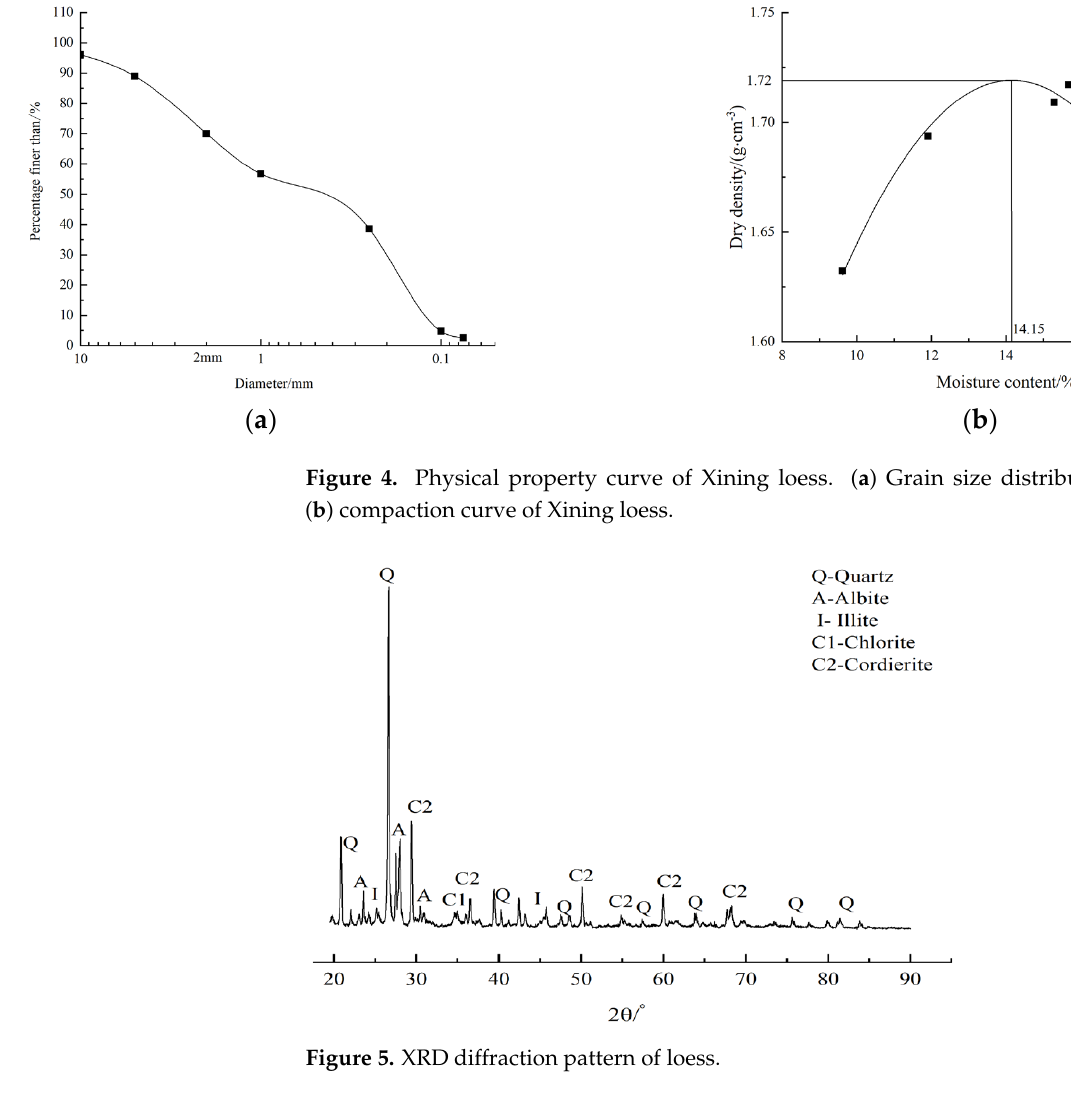
Figure 6. Microscopic image of loess.